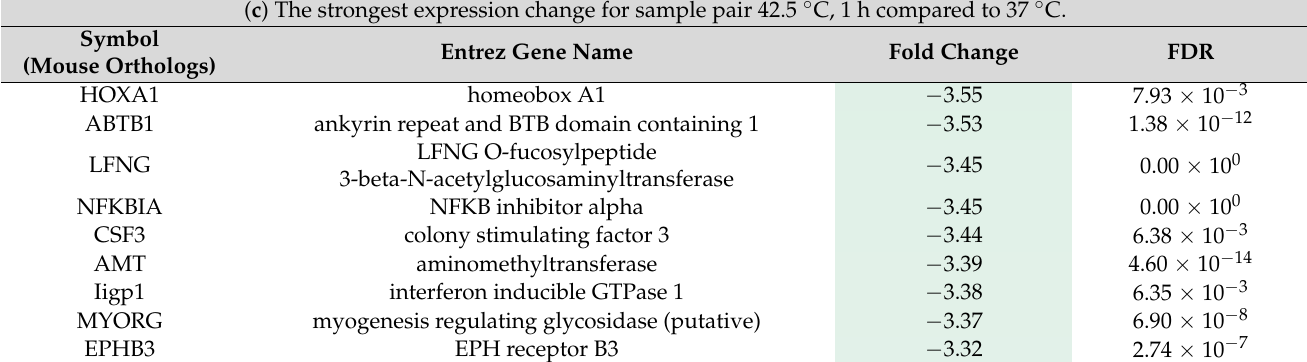
Table 1. Cont. ( c ) The strongest expression change for sample pair 42.5 ◦ C, 1 h compared to 37 ◦ C.